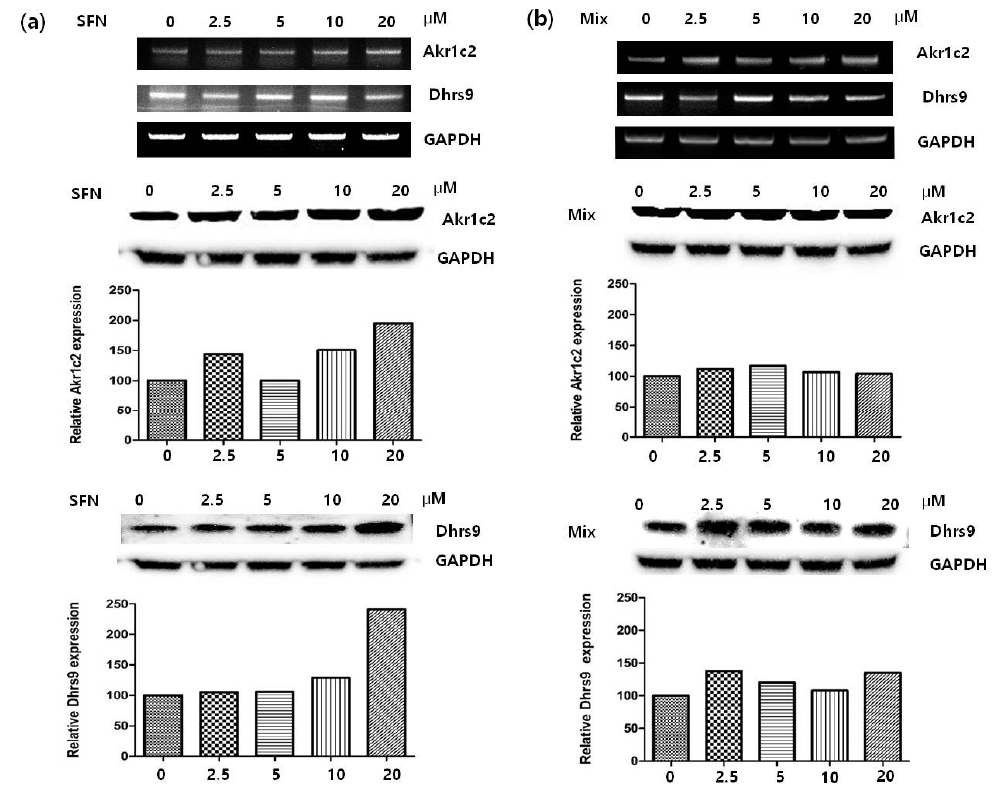
Figure 4. The RNA and protein expression levels of Akr1c12 and Dhrs9. The levels were de tected by RT-PCR and Western blot by treatment with ( a ) sulforaphane and ( b ) a mixture of biotin, dexpanthenol, and l-menthol in dose-dependent manner. Hepa1c1c7 cells were treated with various concentrations of (2.5–20 µ M) with sulforaphane and a mixture of biotin, dexpanthenol, and L-menthol.